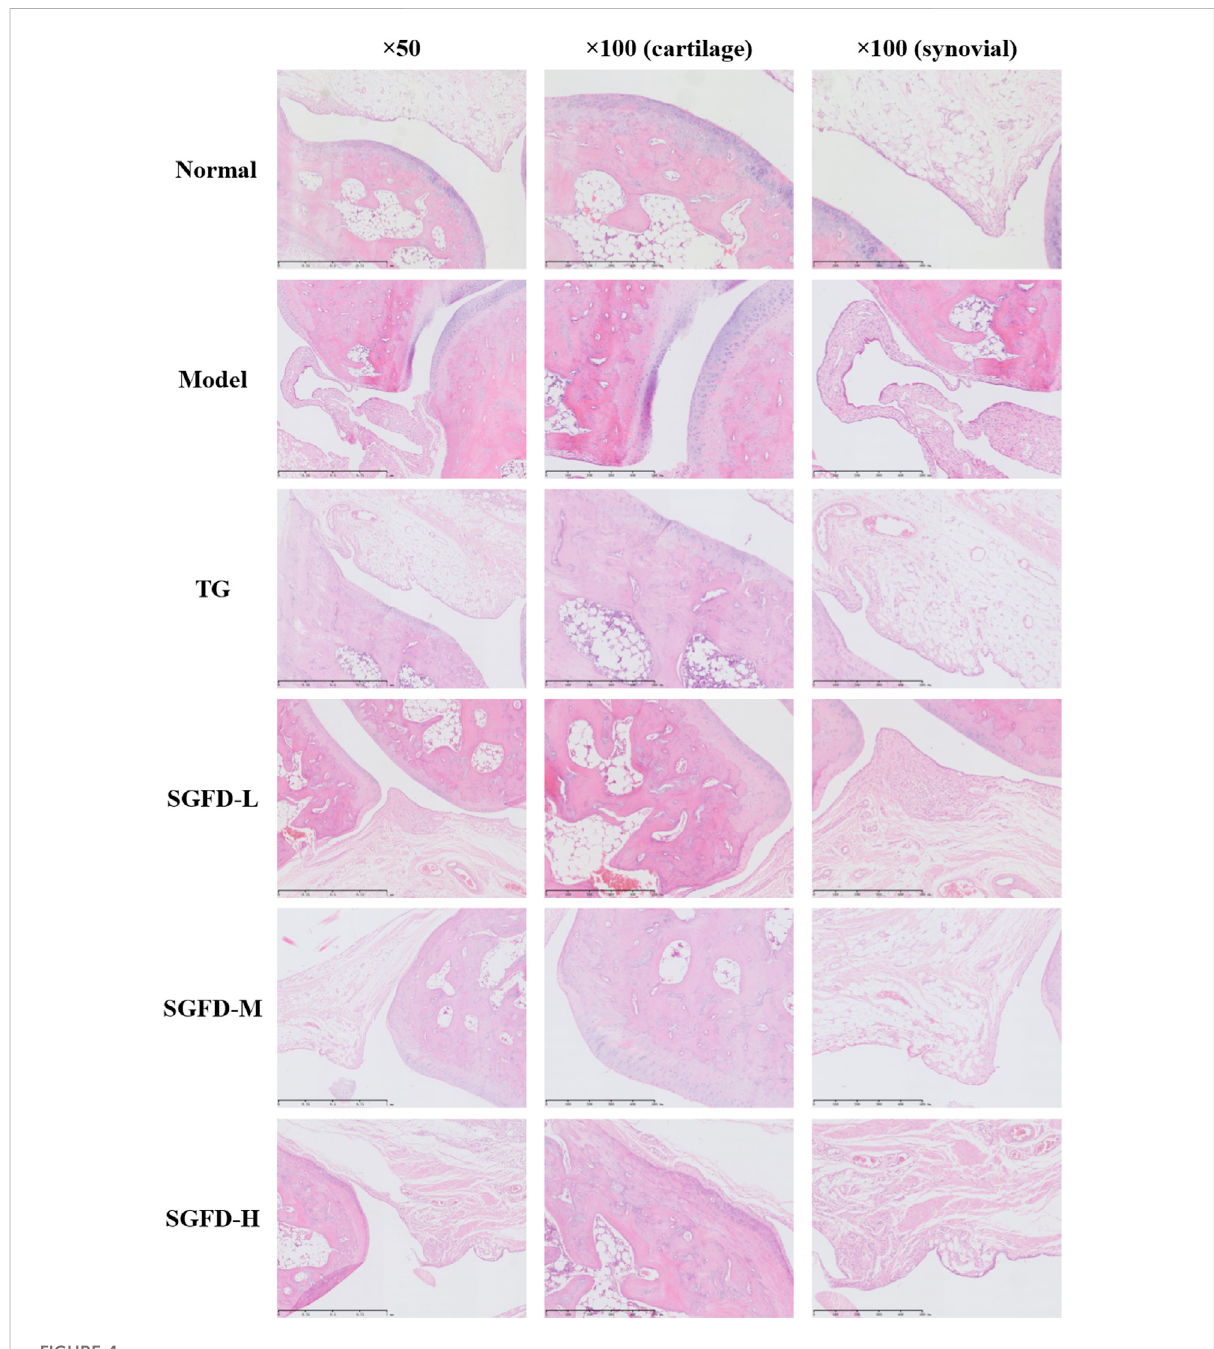
FIGURE 4 Effect of SGFD on pathological changes of the ankle joint in RA